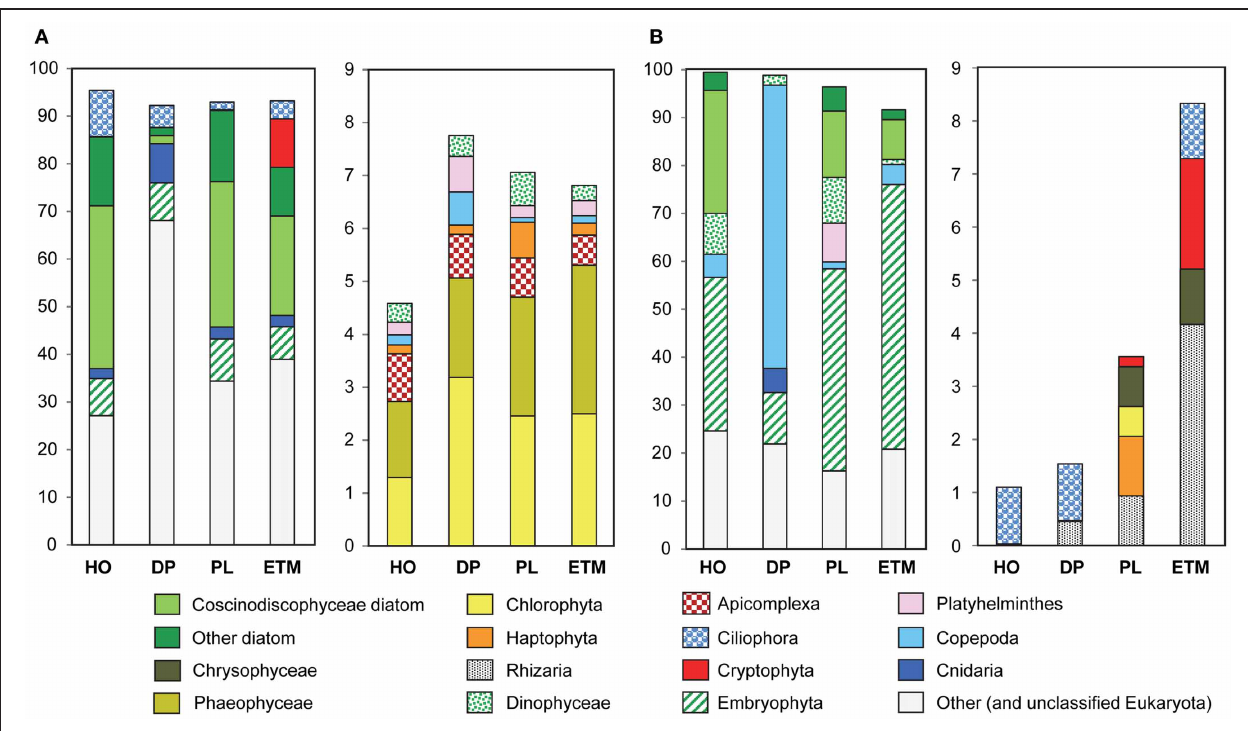
FIGURE 2 | Taxonomic composition of the domain Eukaryota in 3- µ m metagenomes, indicated by habitats. HO, hypoxic water; DP, deep ocean bottom; PL, plume; ETM, estuarine turbidity maxima. The left panel in both (A) and (B) represents taxon abundance for > 90% of total, and the right panel shows the remaining 10% (only taxa with abundances above 0.5% threshold in at least one sample). Bars show taxon abundance in percentage